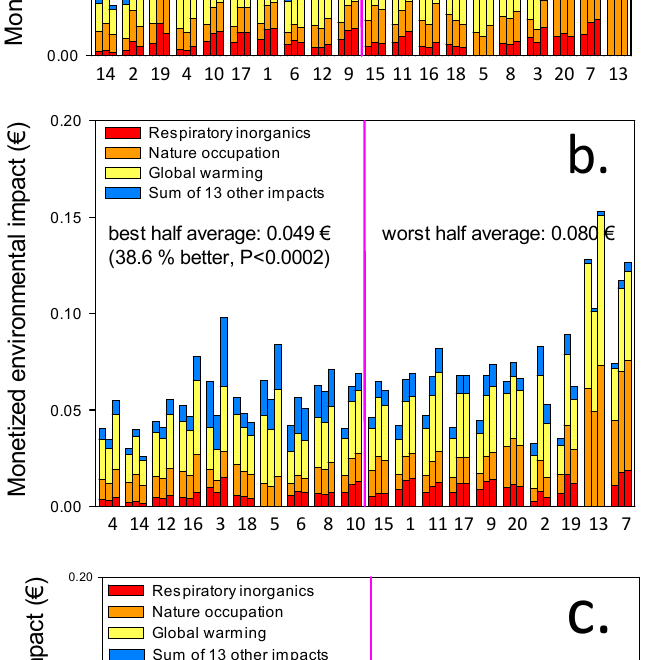
Figure 3. Monetized environmental impact of 20 protein and energy fortified texture modified snacks. Numbers below each set of three bars refer to alphabetically ordered recipe numbers in Figure 1. The first bar in each set of three bars indicates impact per 100 g snack, the second impact per MJ energy content, and the third bar in each set indicates impact per kg protein in the snacks. The colors indicate impact categories. Top figure ( a ) arranged by increasing overall impact relative to weight; middle figure ( b ) arranged by increasing overall impact relative to energy content; bottom figure ( c ) arranged by increasing overall impact relative to protein content. The average of the best and worst half in terms of monetized environmental impact is given in the figure together with the relative difference and associated significance level ( t